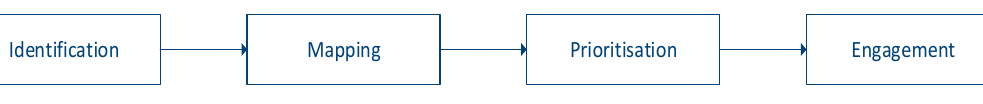
Figure 11. Structured four-step approach for stakeholder analysis.